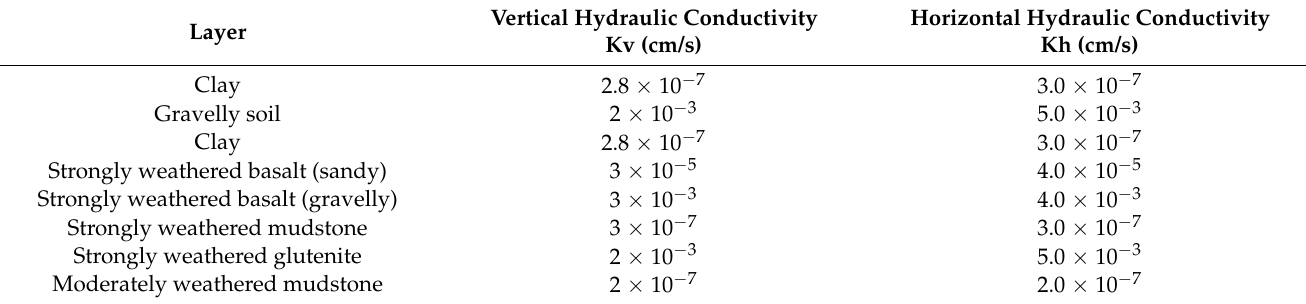
Figure 12. ( a – c ) were surface floods taken during the rainy season. Table 1. Permeability of each